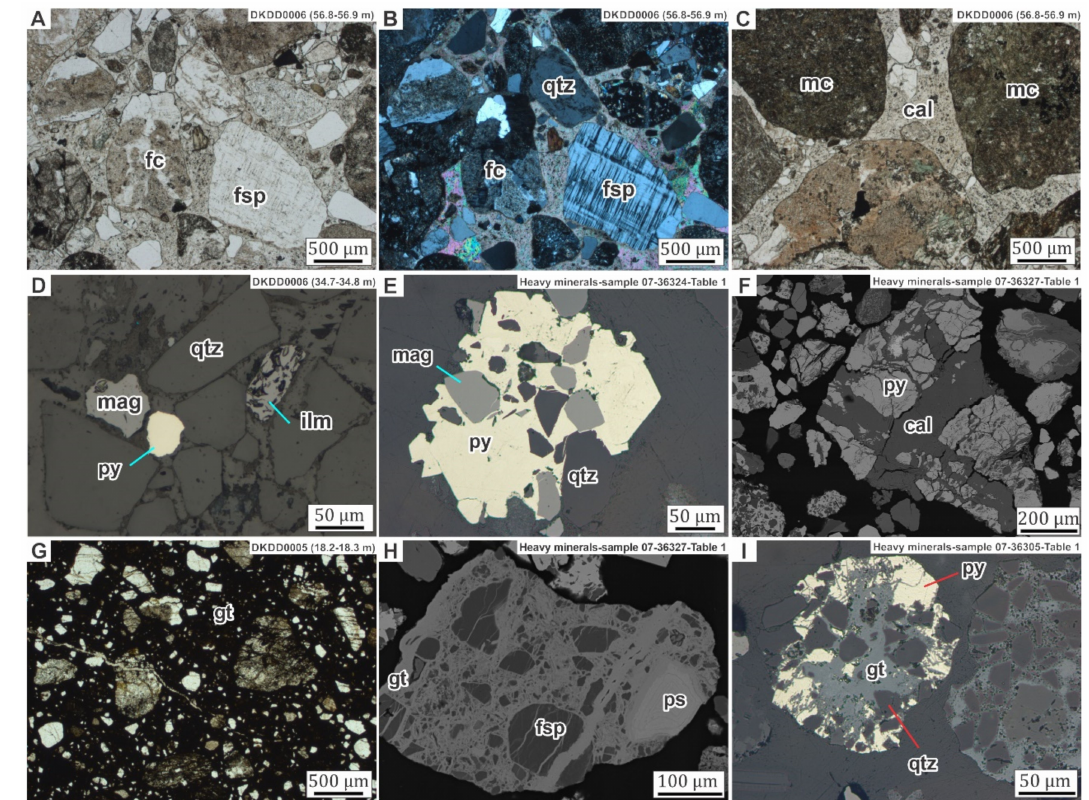
Figure 5. Petrography of the Permian diamictites ( A – C ) from drill holes DKDD0006 and DKDD0005 and heavy mineral concentrates. ( A – C ) Unweathered diamictites consist of quartz (qtz) and partially altered and fresh feldspars (fsp) in liberated grains and felsic clasts (fc) and mafic clasts (mc) in a matrix of quartz and calcite (cal) cement. ( D ) Opaque minerals pyrite (py), ilmenite (ilm), and magnetite (mag) in the diamictite matrix. ( E ) Pyrite (py) cementing quartz (qtz) and magnetite (mag). ( F ) Pyrite (py) and calcite (cal) cement of the unweathered calcareous diamictite. ( G – I ) Weathered diamictites with Fe oxide (goethite: gt) and Mn oxide (psilomelane: ps) cement replacing feldspars (fsp) and pyrite (py) cement ( I ).